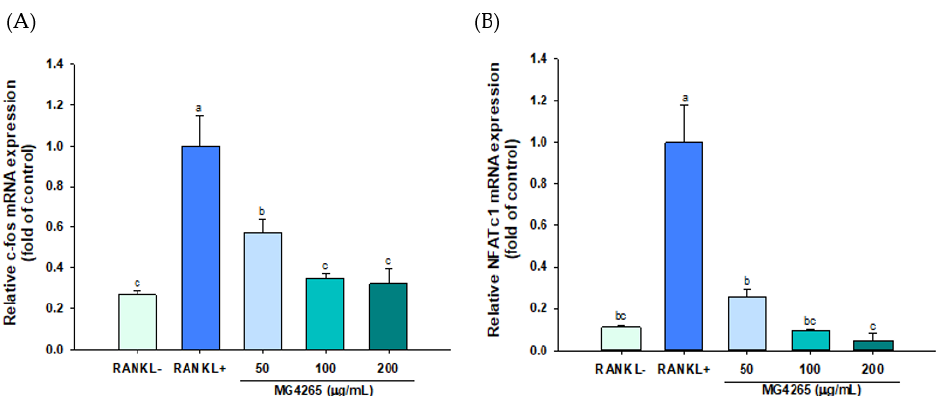
Figure 4. Effect of the SCS of L. salivarius MG4265 on osteoclast-specific transcription factors ( A ) c-Fos and ( B ) NFATc1 mRNA expression in RANKL stimulated RAW 264.7 macrophages. Different letters (a–c) indicate significant difference at p < 0.05.